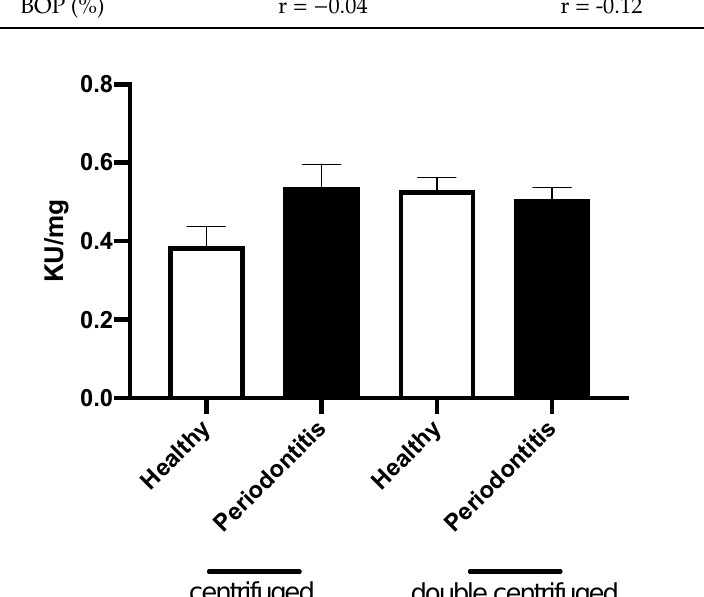
Figure 3. The effect of periodontitis on activity of DNase in centrifuged and double-centrifuged samples. Results are expressed as mean + SEM. No differences were found between healthy and periodontitis samples.